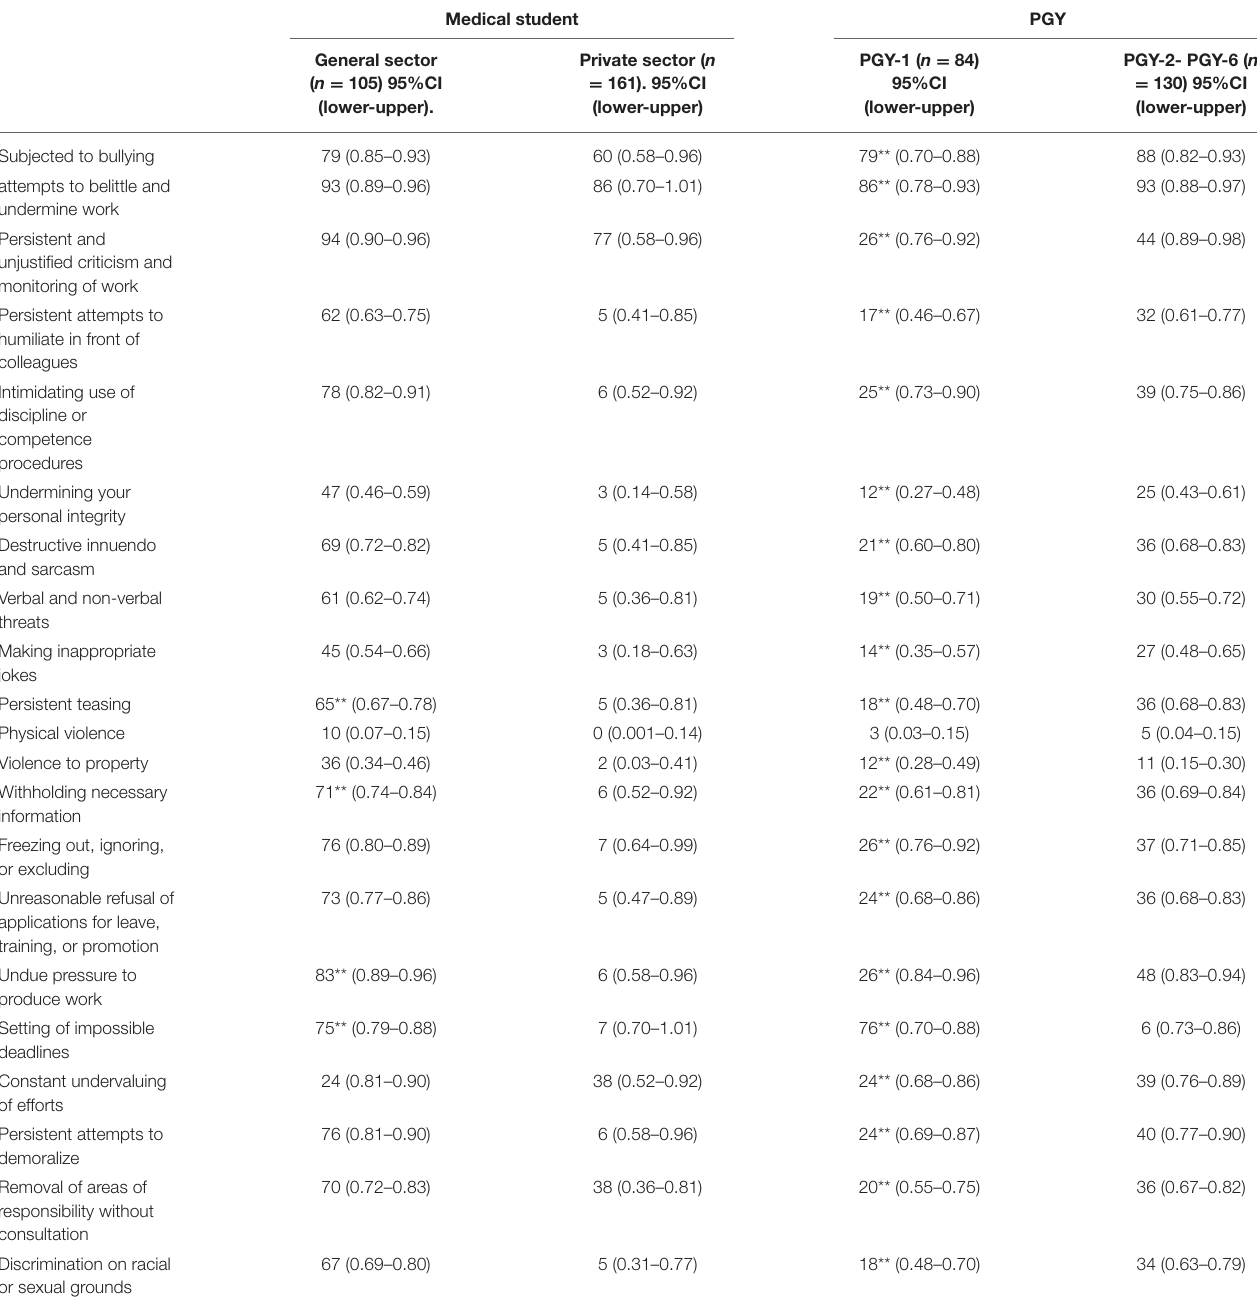
TABLE 4 | Percentages of bullying behaviors by professional